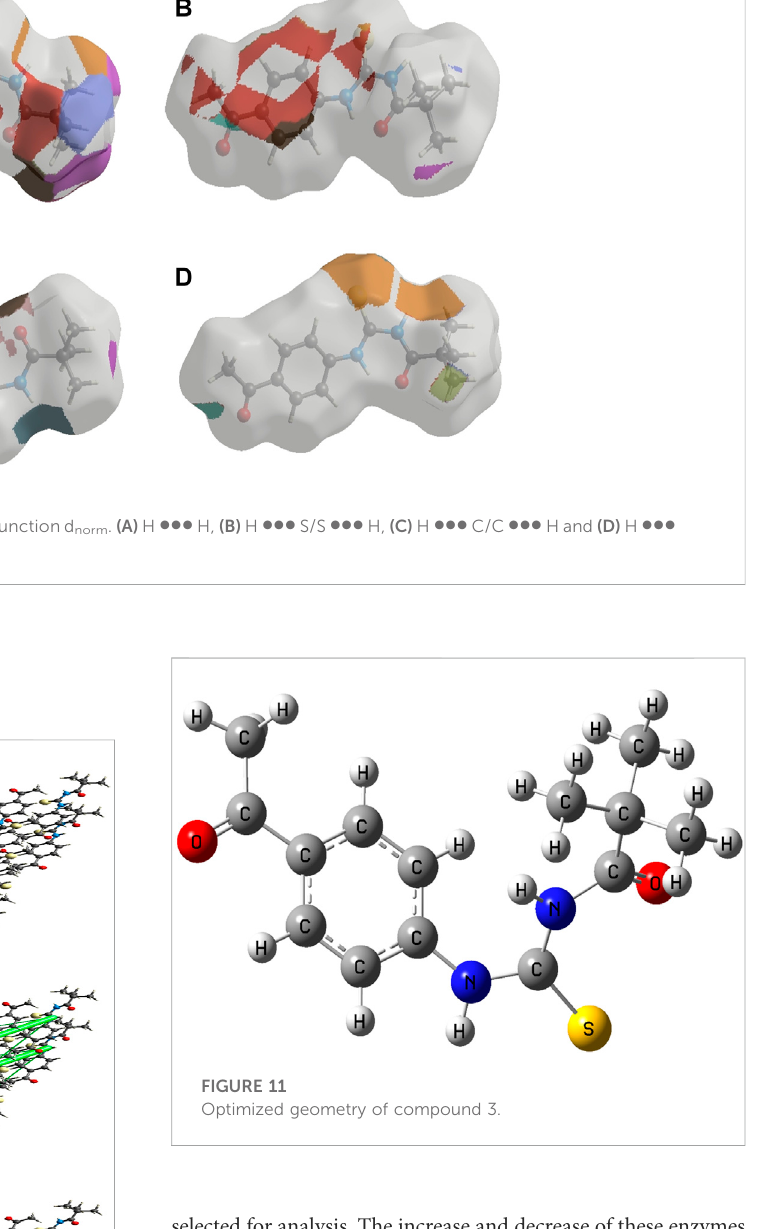
FIGURE 11 Optimized geometry of compound